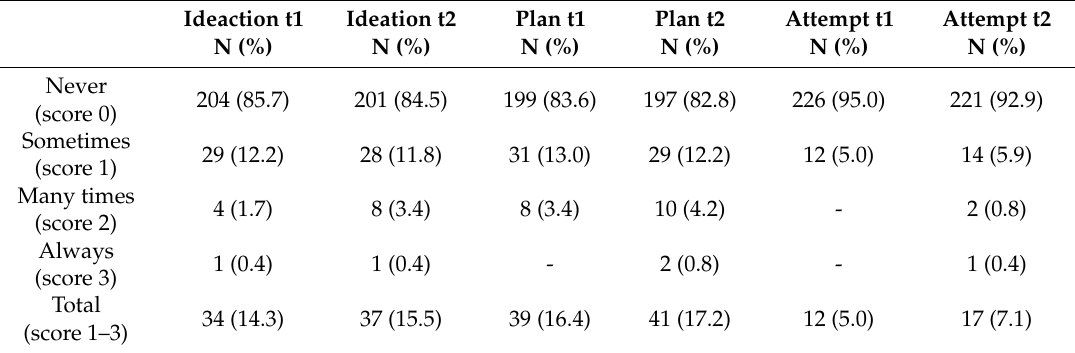
Table 3. Frequency Distribution of the score of Suicide